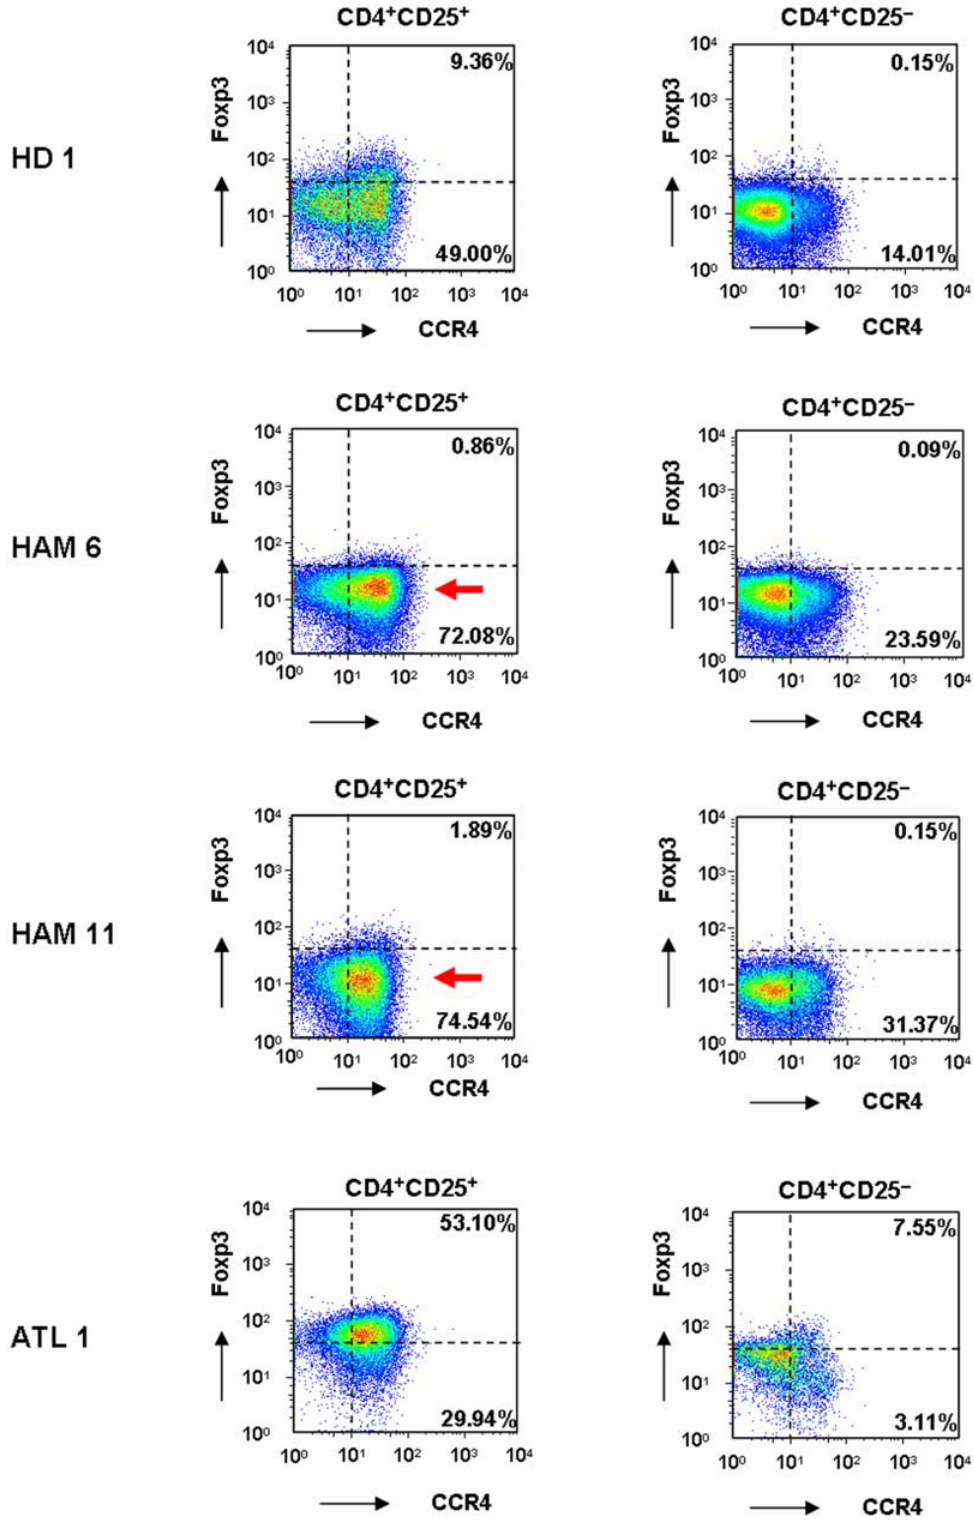
Figure 2. Different expression levels of FoxP3 in CD4 + CD25 + CCR4 + T cells between HD, HAM/TSP, and ATL. PBMCs from 1 healthy donor (HD 1), 2 HAM/TSP patients (HAM 6, HAM 11), and 1 ATL patient (ATL 1) were stained for CD4, CD25, CCR4, and intracellular Foxp3. CD4 + CD25 + or CD4 + CD25 2 cells were gated, and the expression levels of CCR4 and Foxp3 were plotted. The percentages of CCR4 + Foxp3 + cells and CCR4 + Foxp3 2 cells in CD4 + CD25 + or CD4 + CD25 2 cells are indicated in each panel. The arrow indicates the increased number of cells with low Foxp3 expression levels in HAM/TSP CD4 + CD25 + CCR4 + T cells.